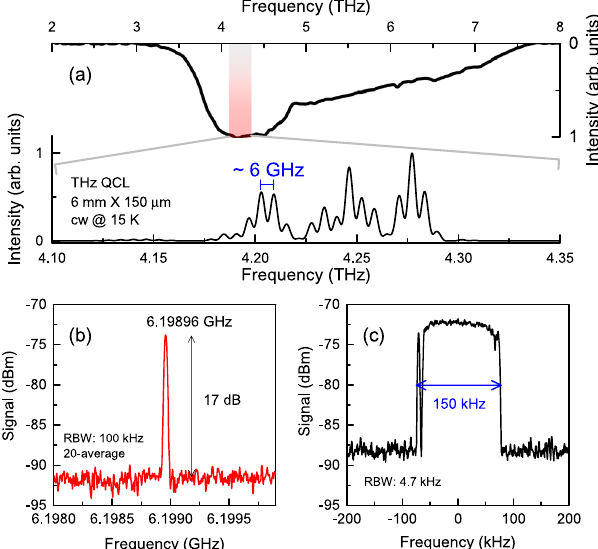
Figure 3. Fast detection of terahertz light. ( a ) The emission spectrum of a 6-mm long terahertz QCL recorded in continuous wave mode at 15 K. The photoresponse spectrum of the terahertz QWP is shown for comparison. The reddish region shows the frequency range of the bottom X axis for the QCL measurement. ( b ) RF spectrum measured using the fast terahertz QWP. ( c ) RF spectrum recorded with the “Max hold” function of the spectrum analyser. The time duration for the “Max hold” measurement is 3